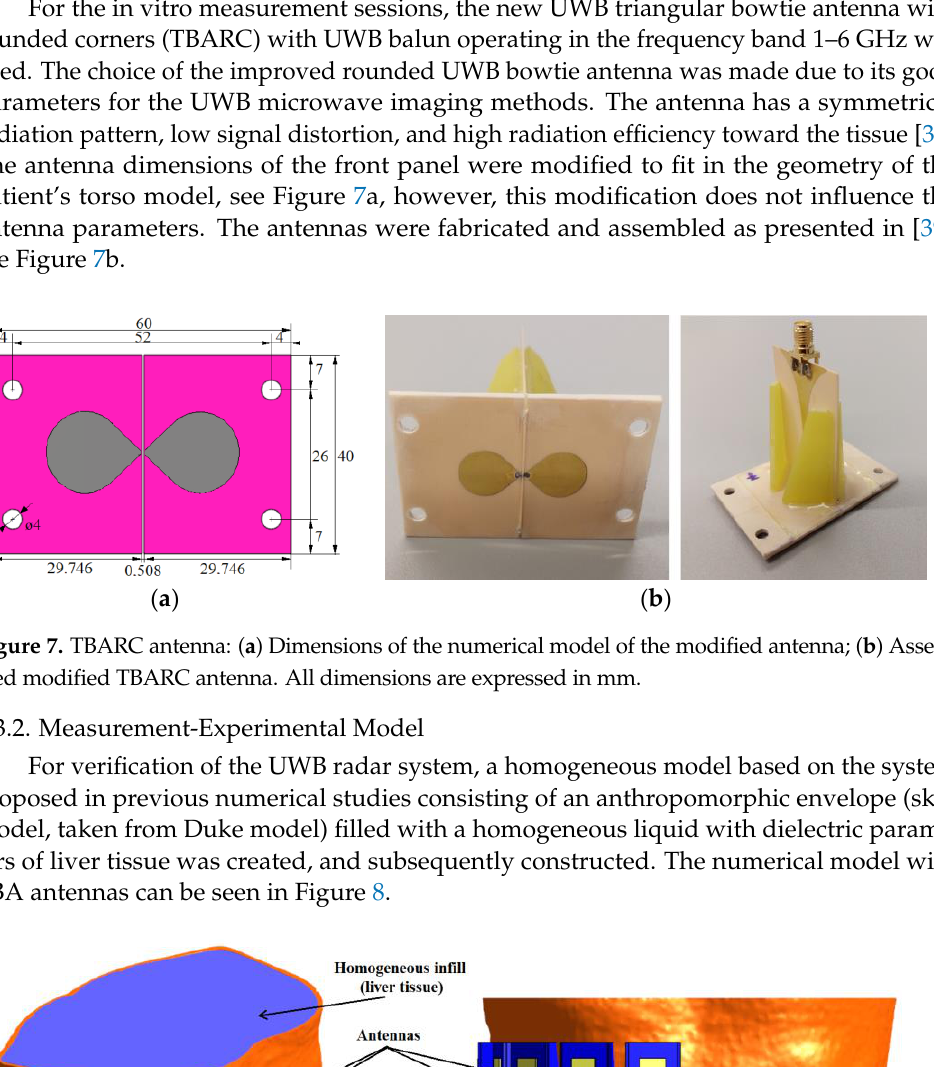
Figure 6. Insertion steps 1–8 of the ablation catheter.